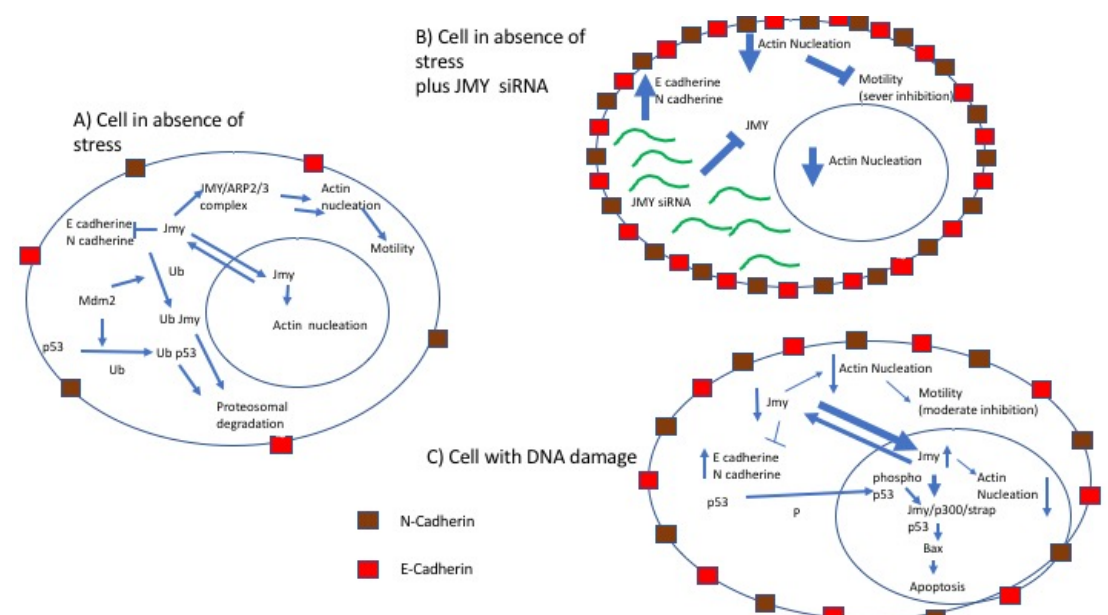
Figure 3. Model of JMY-mediated co-ordination between cell motility and DNA damage response in cell lines. A model of how JMY links p53 response to DNA damage and cell motility in cell lines. ( A ) In a motile cell, in absence of stress, the amount of JMY in the nucleus and in the cytoplasm are maintained in equilibrium. The available JMY protein in the cytoplasm inhibits E and N cadherin adhesion molecules in a dose dependent fashion and induces actin nucleation for cell motility both in an Arp2/3 dependent and independent fashion. ( B ) If such a cell is treated with siRNA targeting JMY, the inhibition of JMY transcription leads to a strong upregulation of the E and N cadherins and a reduction of actin nucleation, attenuating cell motility. ( C ) When DNA damage occurs, a more drastic drop in motility is observed. The explanation for this drastic drop in motility is the translocation of JMY from the cytoplasm to the nucleus diminishing the cytoplasmic JMY level. This however is in part compensated for by the overall increase of JMY levels following the DNA damage. This implies that JMY is capable of producing both forms of biochemical actin filaments. Having both forms of biochemical actin polymerization would also imply that JMY’s contribution to cell motility is via its nucleation filament and that JMY can promote rapid assembly of a new actin network by harnessing its ability to first nucleate new mother filaments and then activate Arp2/3 to branch off these filaments. This duality of JMY localization and functions in the cytoplasm and nucleus might be a characteristically and evolutionarily gained advantage